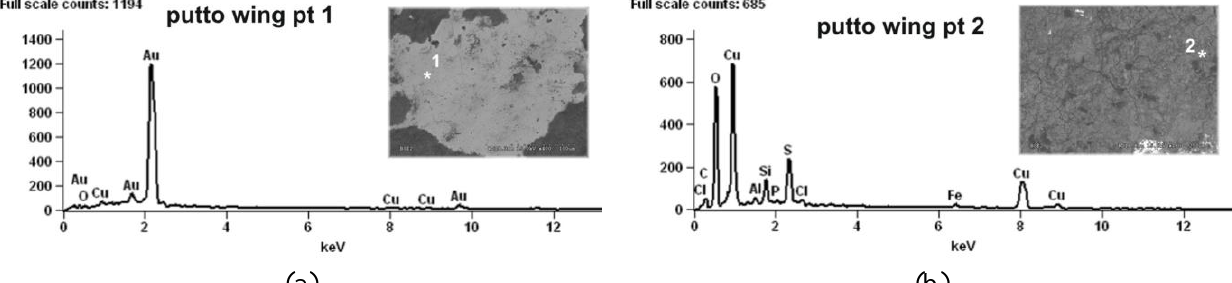
Figure 17. EDS spectrograms of the chemical composition at the points indicated by the numbers (small SEM photographs): (a) gilding; (b)